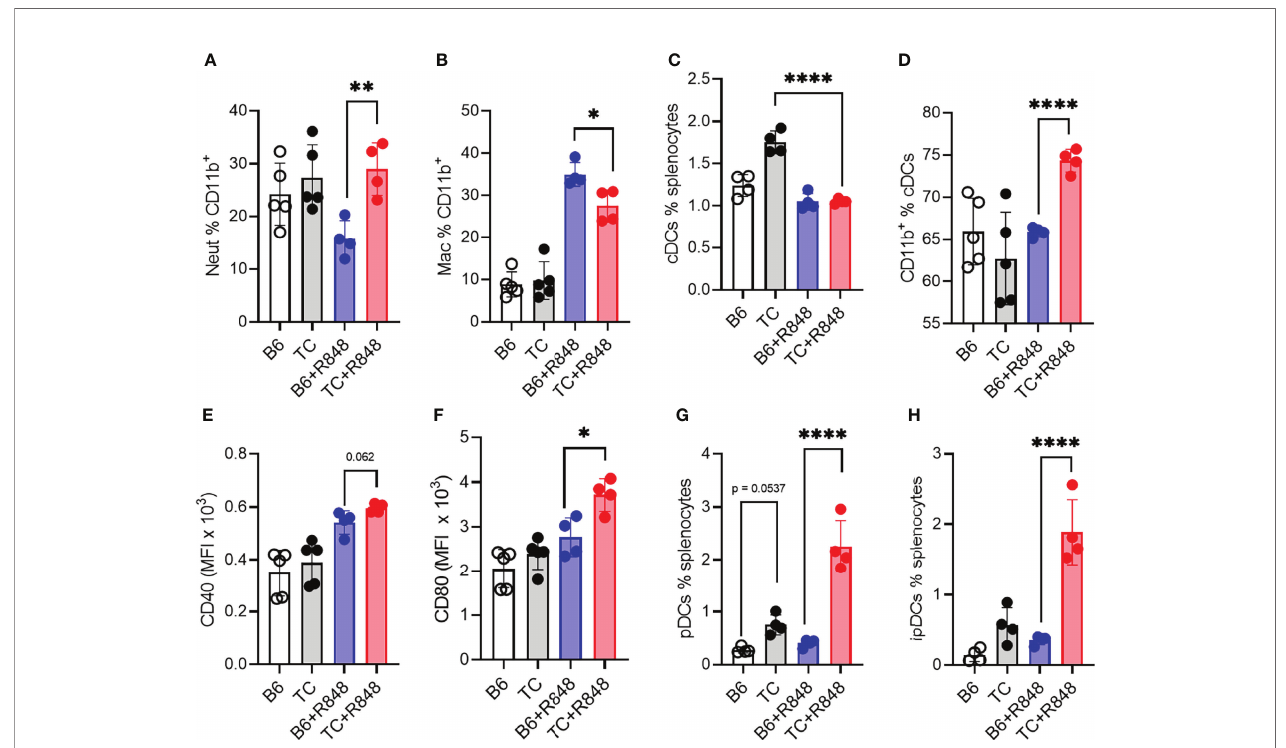
FIGURE 6 | TLR7 activation enhanced myeloid cell activation in TC mice. B6 and TC mice were treated with R848 for 1 week and their splenic myeloid cell phenotypes were compared to untreated age-matched control mice. Frequency of neutrophils (A) and macrophages (B) in CD11b + cells. Frequency of cDCs in splenocytes (C) and CD11b + cells in cDCs (D) . Expression of CD40 (E) and CD80 (F) on cDCs. Frequency of pDCs (G) and ipDCs (H) . n = 4 - 5 per group. 1-way ANOVA, with multiple comparison tests, *: P < 0.05, **: P < 0.01, ****: P <